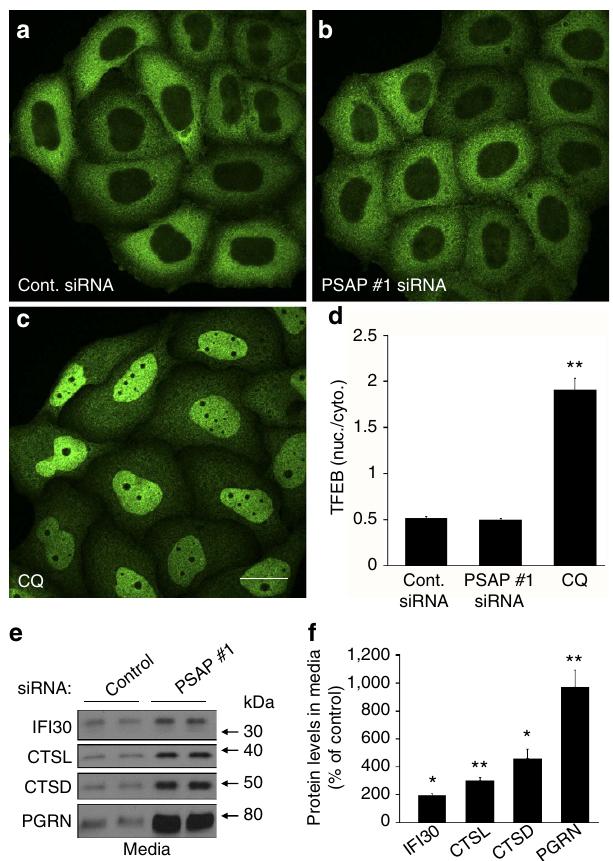
Figure 4 | PSAP knockdown does not affect TFEB localization and increases extracellular PGRN more robustly than other lysosomal proteins. ( a – c ) GFP immunofluorescence images of HeLa cells that stably express TFEB-GFP. Images were acquired after cells were transfected with 20nM of either a control ( a ) or PSAP siRNA ( b ), or post treatment with chloroquine (CQ) ( c ). ( d ) Quantification of the effects of siRNA transfection or CQ treatment on the nuclear/cytoplasmic ratio of TFEB-GFP ( n ¼ 21 fields from three independent experiments, totalling Z 70 cells per group). ( e ) Immunoblot of HeLa cell media from 20nM control or PSAP siRNA transfections. ( f ) Quantification of IFI30, cathepsin L (CTSL), cathepsin D (CTSD) and PGRN protein levels in HeLa cell media post PSAP knockdown ( n ¼ 4 per group). Graphed values represent the mean ± s.e.m. *Differs from control-transfected cells, P o 0.001; ** P o 0.0005 by one-way ANOVA ( d ) or Student’s t -tests ( f ). Scale bar, 10 m m.